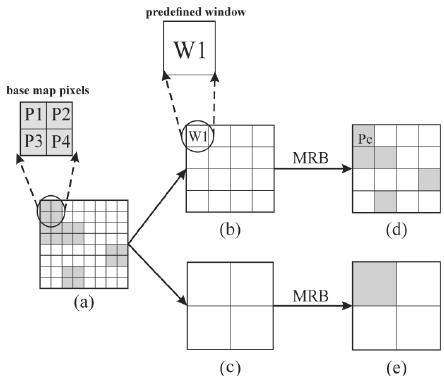
Figure 6. An example of upscaled maps derived by Majority Rule Based aggregation (MRB). Two classes are in it. Class 1 is with the gray color. Class 2 is with the white color. ( a ) is the base map. ( b, c ) are predefined windows for implementing upscaling, ( d, e ) are two upscaled maps at two different resolutions.